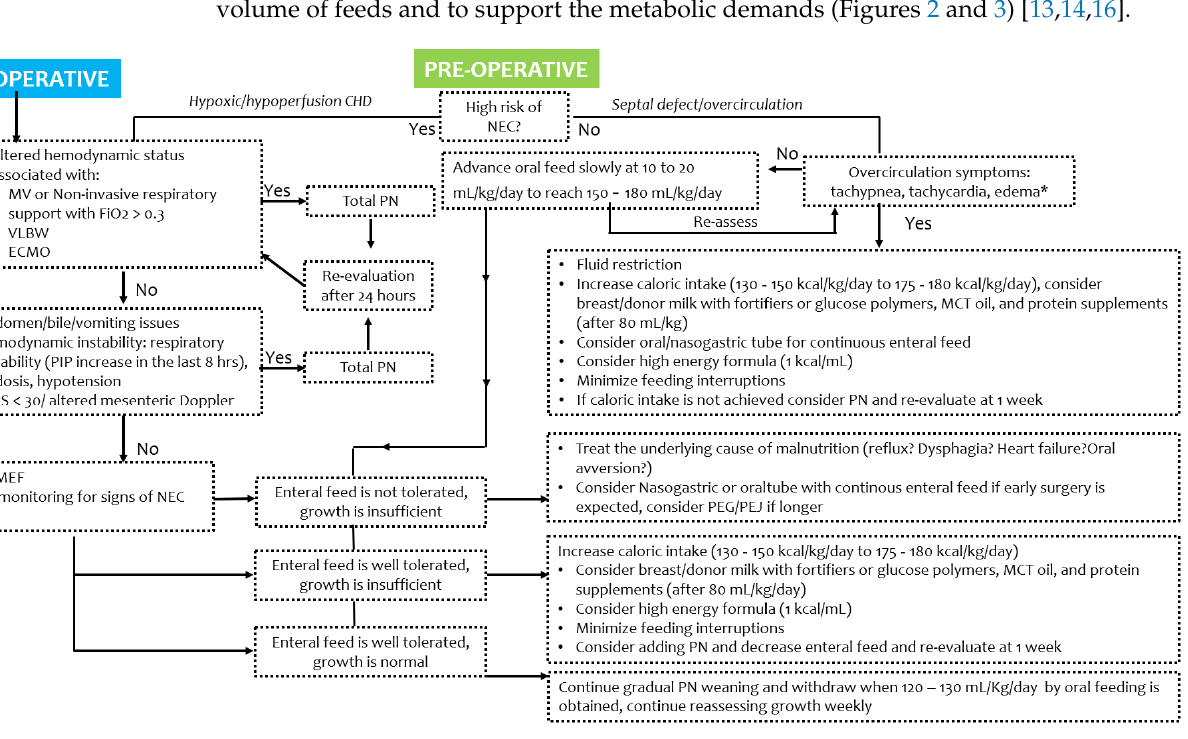
Figure 2. Proposed algorithm to optimize nutrition in newborn infants with congenital heart diseases. MV, mechanical ventilation; VLBW, very low birth weight; PIP, positive inspiratory pressure; MEF, minimal enteral feeding; PN, parenteral nutrition.